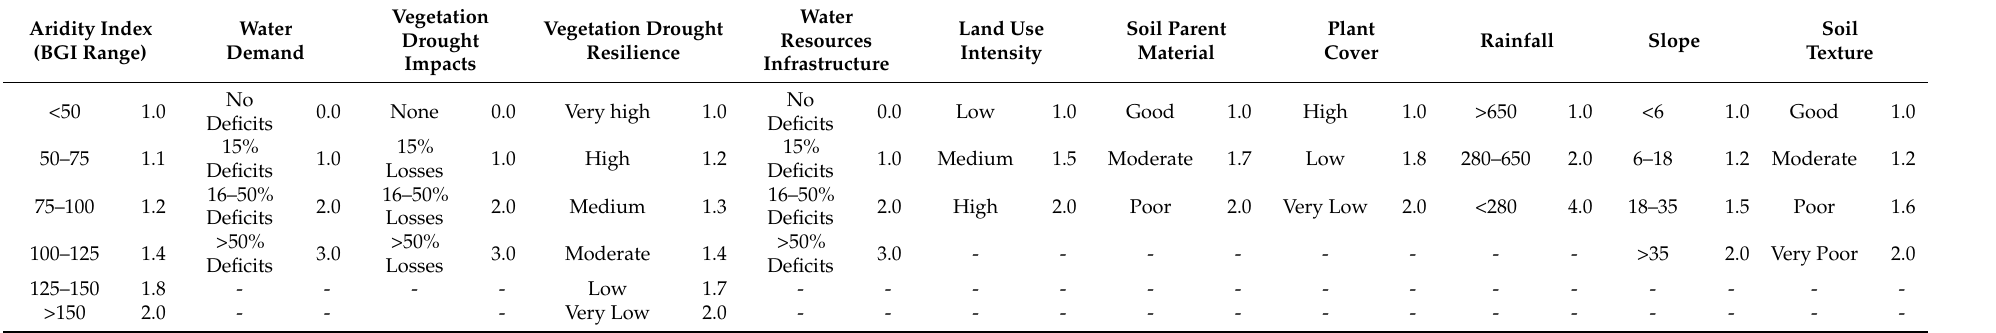
Table 3. WLDI components and degradation scales